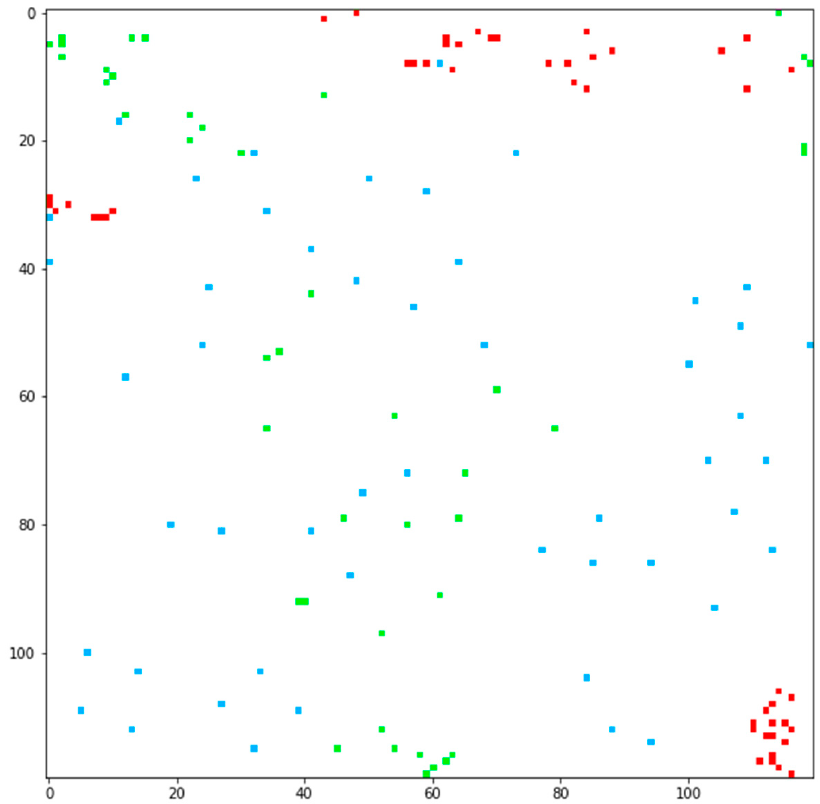
Figure 3. Final 3-channel RGB color image created using grayscale images generated by t-SNE, kPCA (cosine), and UMAP, which are the image transformers with the highest F1-score values.